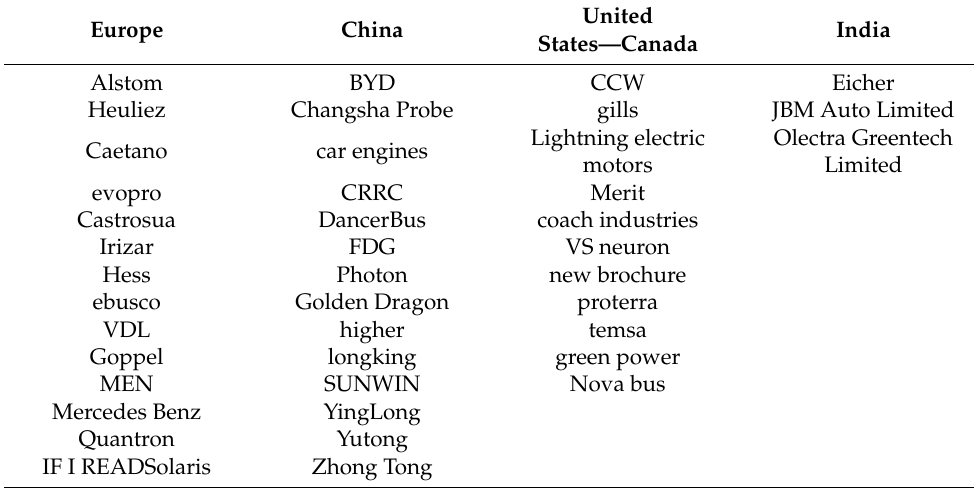
Figure 1. Number of electric buses introduced in Europe (Based on: Sustainable Bus [7,8] and European Automobile Manufacturers Association [9,10]. Table 7. Bus brands with electric buses in their catalogue. Based on: ZETI tool [11], ZeEUS [12] and ZEBRA